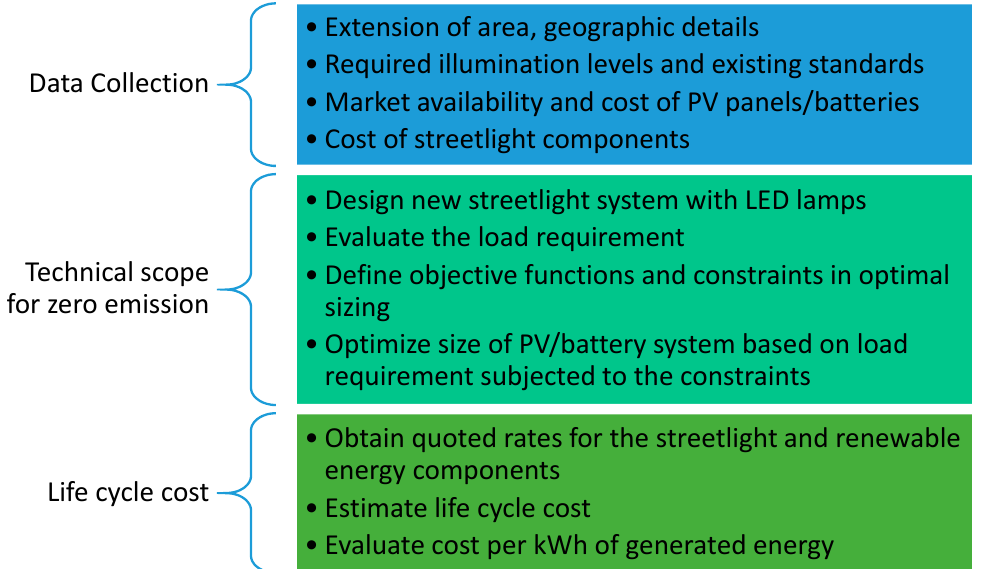
Figure 2. Methodology for economic analysis to set up new streetlight system powered by PV/battery system for zero emissions.